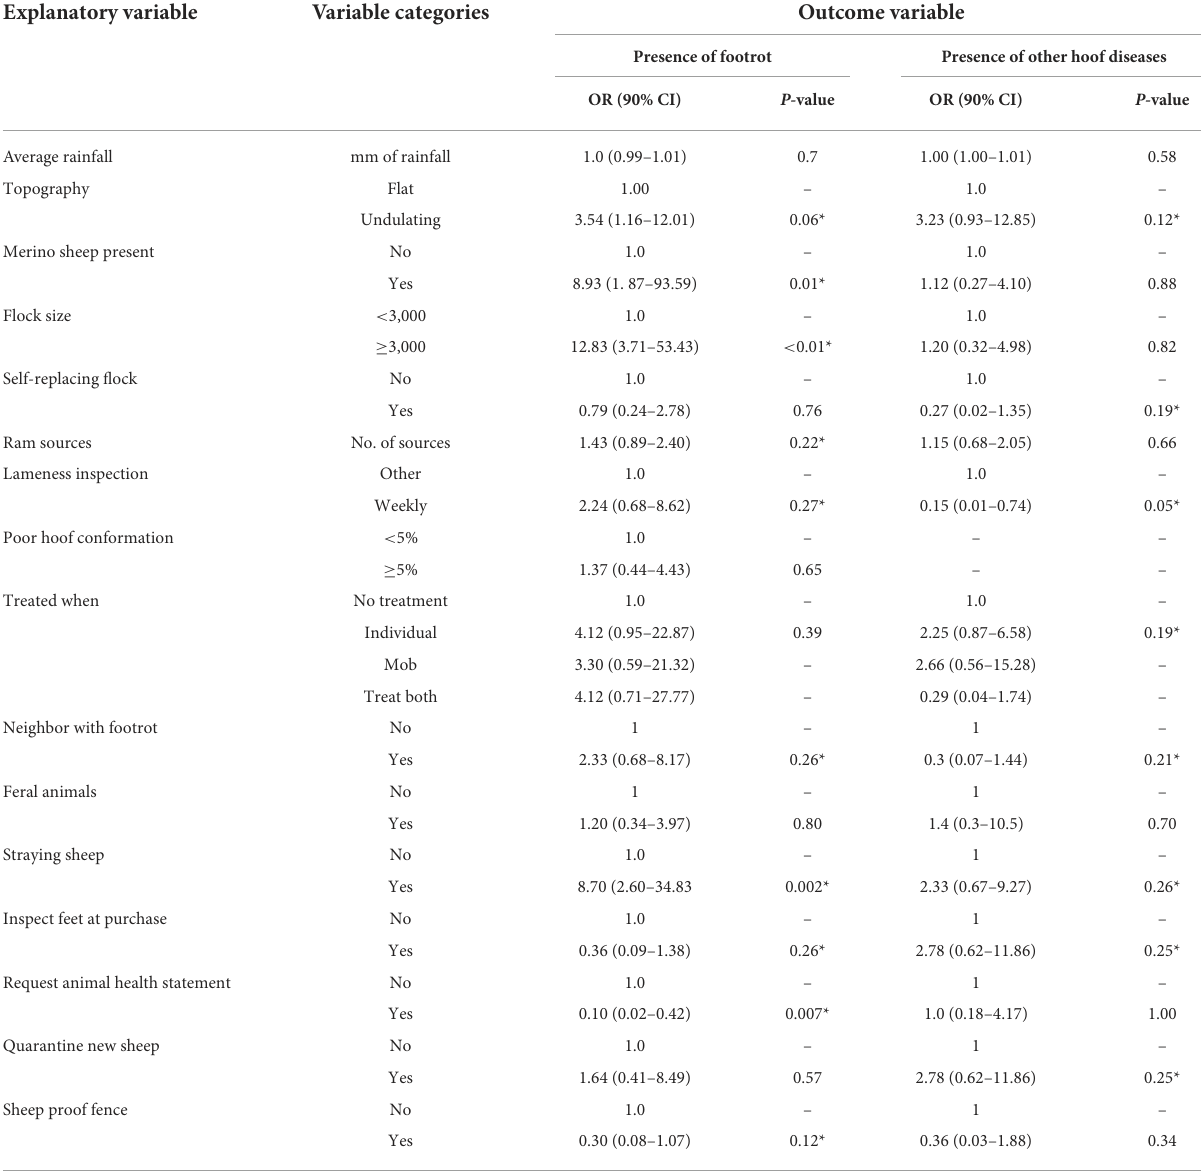
TABLE 5 The explanatory variables and their definition/categories and the values from the univariable analyses for each outcome, footrot or other hoof diseases. Explanatory